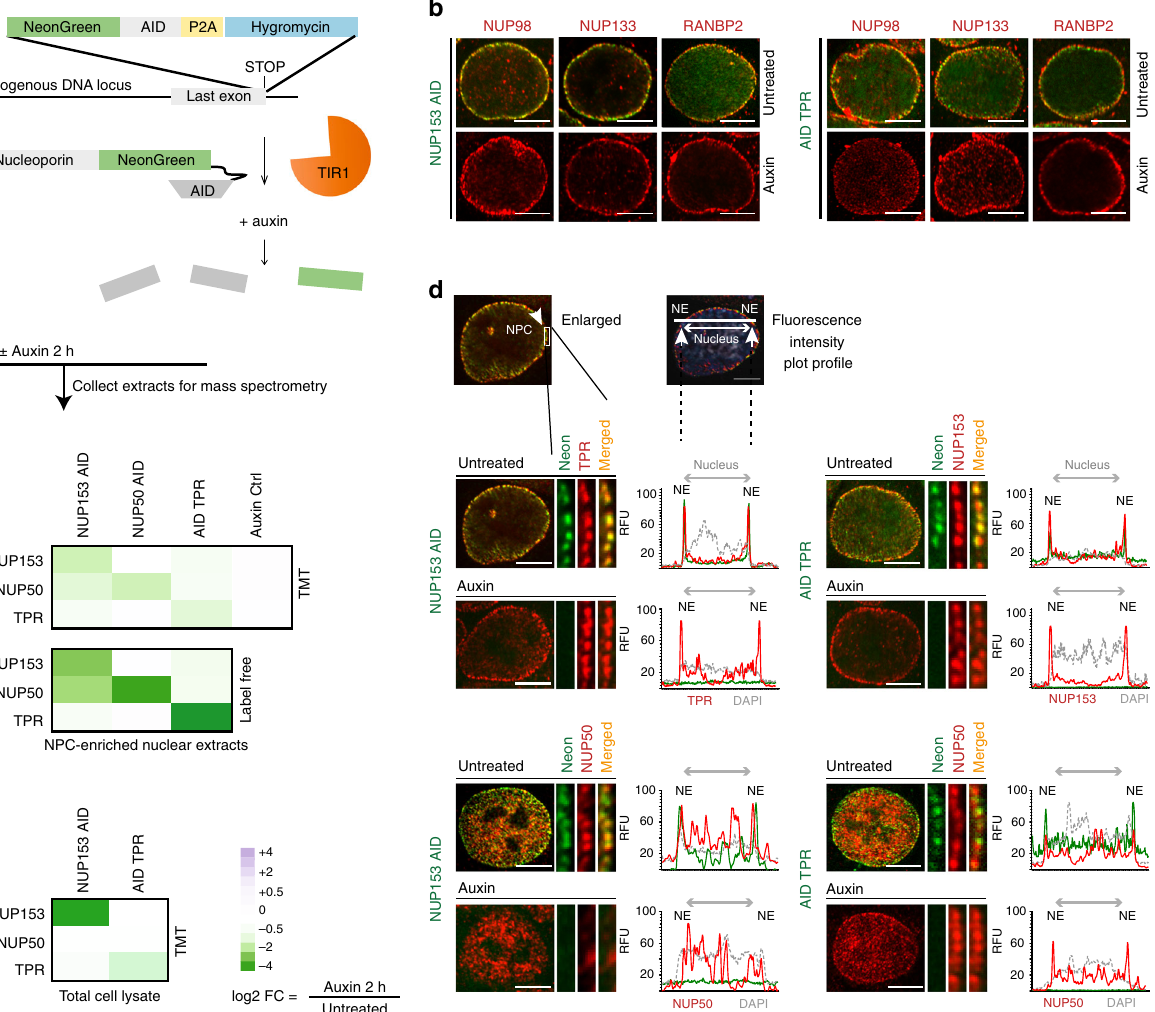
Fig. 1 Stability of the assembled nuclear pore upon rapid loss of BSK-NUPs. a Schematic of CRISPR/Cas9-based tagging of nucleoporin genes and subsequent degradation of the AID-fused proteins. Each AID cell line is biallelically tagged. b NUP98, NUP133, and RANBP2 localization is not altered upon loss of NUP153 or TPR (4 h of auxin treatment). AID-NG tagged NUP153 and TPR proteins are shown in green, antibody-stained NUPs in red. Data are representative of at least three independent experiments. c Heat maps of differential abundance of NUP153, NUP50, and TPR proteins in NPC-enriched nuclear extracts and total cell lysates of the indicated AID-tagged cells 2 h after auxin treatment using TMT-assisted and conventional (label-free) mass spectrometry. Green color indicates a decrease in protein abundance after auxin treatment, log2 scale. Data represent a repeat of one experiment. d Localization of BSK-NUPs in the absence or presence of TPR and NUP153 (4 h of auxin treatment). Plots show line scans of relative fl uorescence intensity (RFU) for BSK-NUPs (AID-NG tagged NUPs are shown in green, antibody-stained NUPs in red) and DNA across the nucleus. DNA was counterstained with DAPI (gray). Note that NUP50 no longer localizes to the nuclear envelope (NE) in the absence of NUP153. Scale bar: 5 µ m. Data are representative of at least three independent experiments. AID auxin-inducible degron, TMT tandem mass tag, FC fold